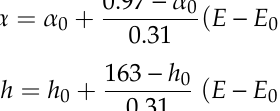
Figure 5. Comparison between measured and calculated data of track cross ‐ section dimensions.